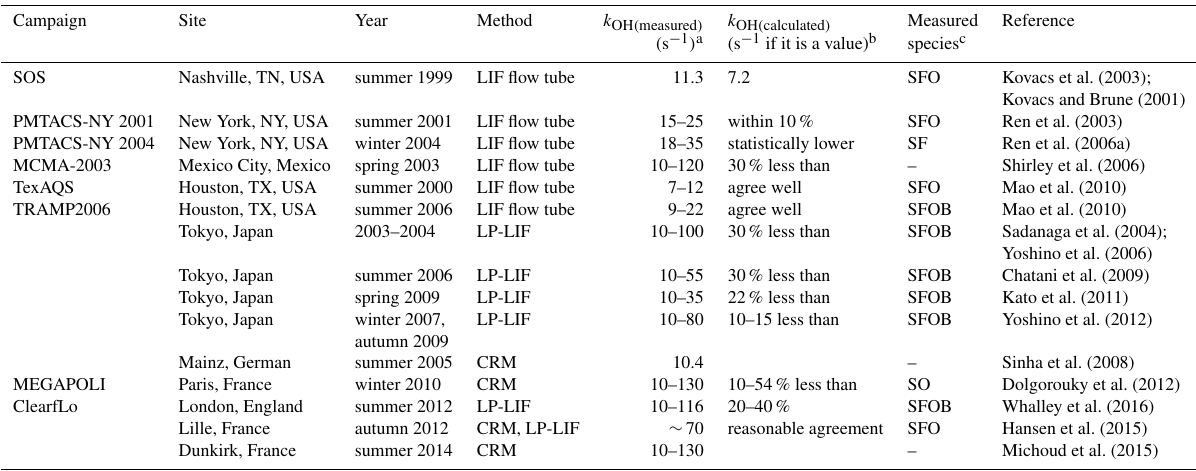
Table 1. Total OH reactivity measurements in urban areas.